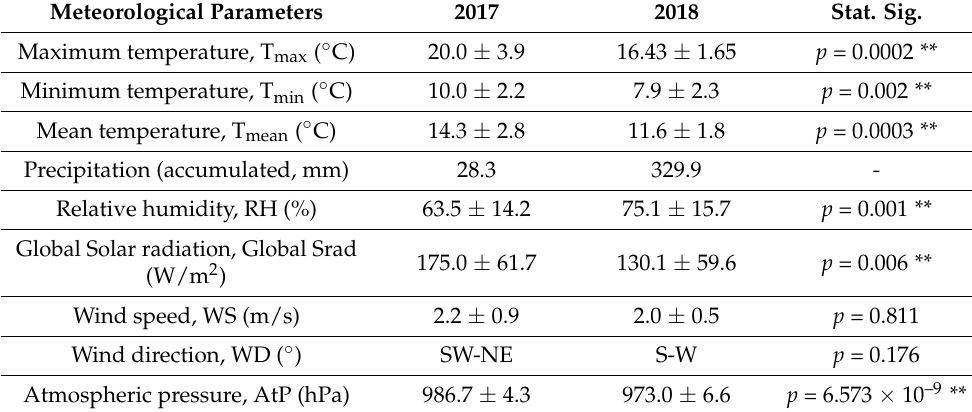
Table 1. Values of meteorological parameters at É vora for the years 2017 and 2018 (averaged for the period 22 February to 19 March of each year, except precipitation). ** statistical significance (Stat. sig.) at 1% ( p < 0.01). Meteorological Parameters 2017 2018 Stat.